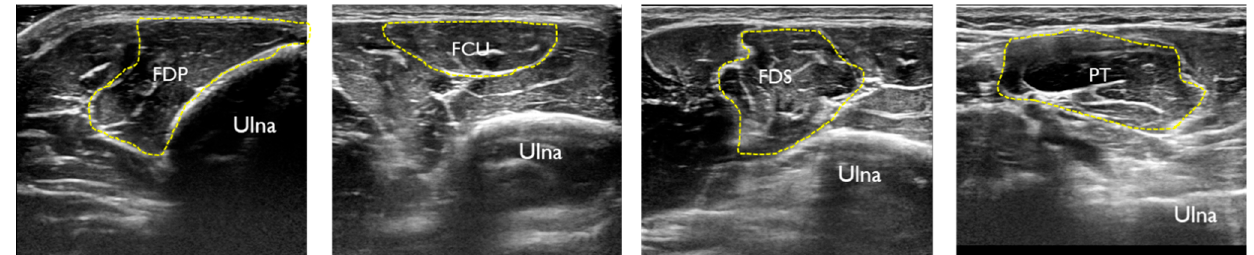
Figure 2. US cross-sectional image of each the flexor pronator muscles at the proximal 20% of the forearm.